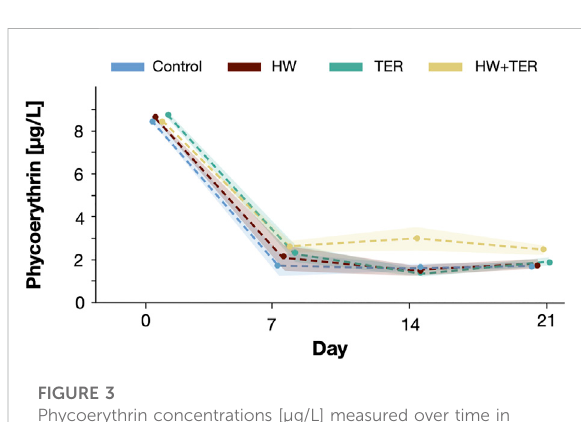
FIGURE 3 Phycoerythrin concentrations [µg/L] measured over time in all treatments: control (blue), heatwave (HW, red), terbuthylazine (TER, green), and the combination of HW and TER (HW + TER, yellow). The shaded area indicates the standard error from the mean. The points indicate the data points and the dashed lines connect the means of these data points. The data points were